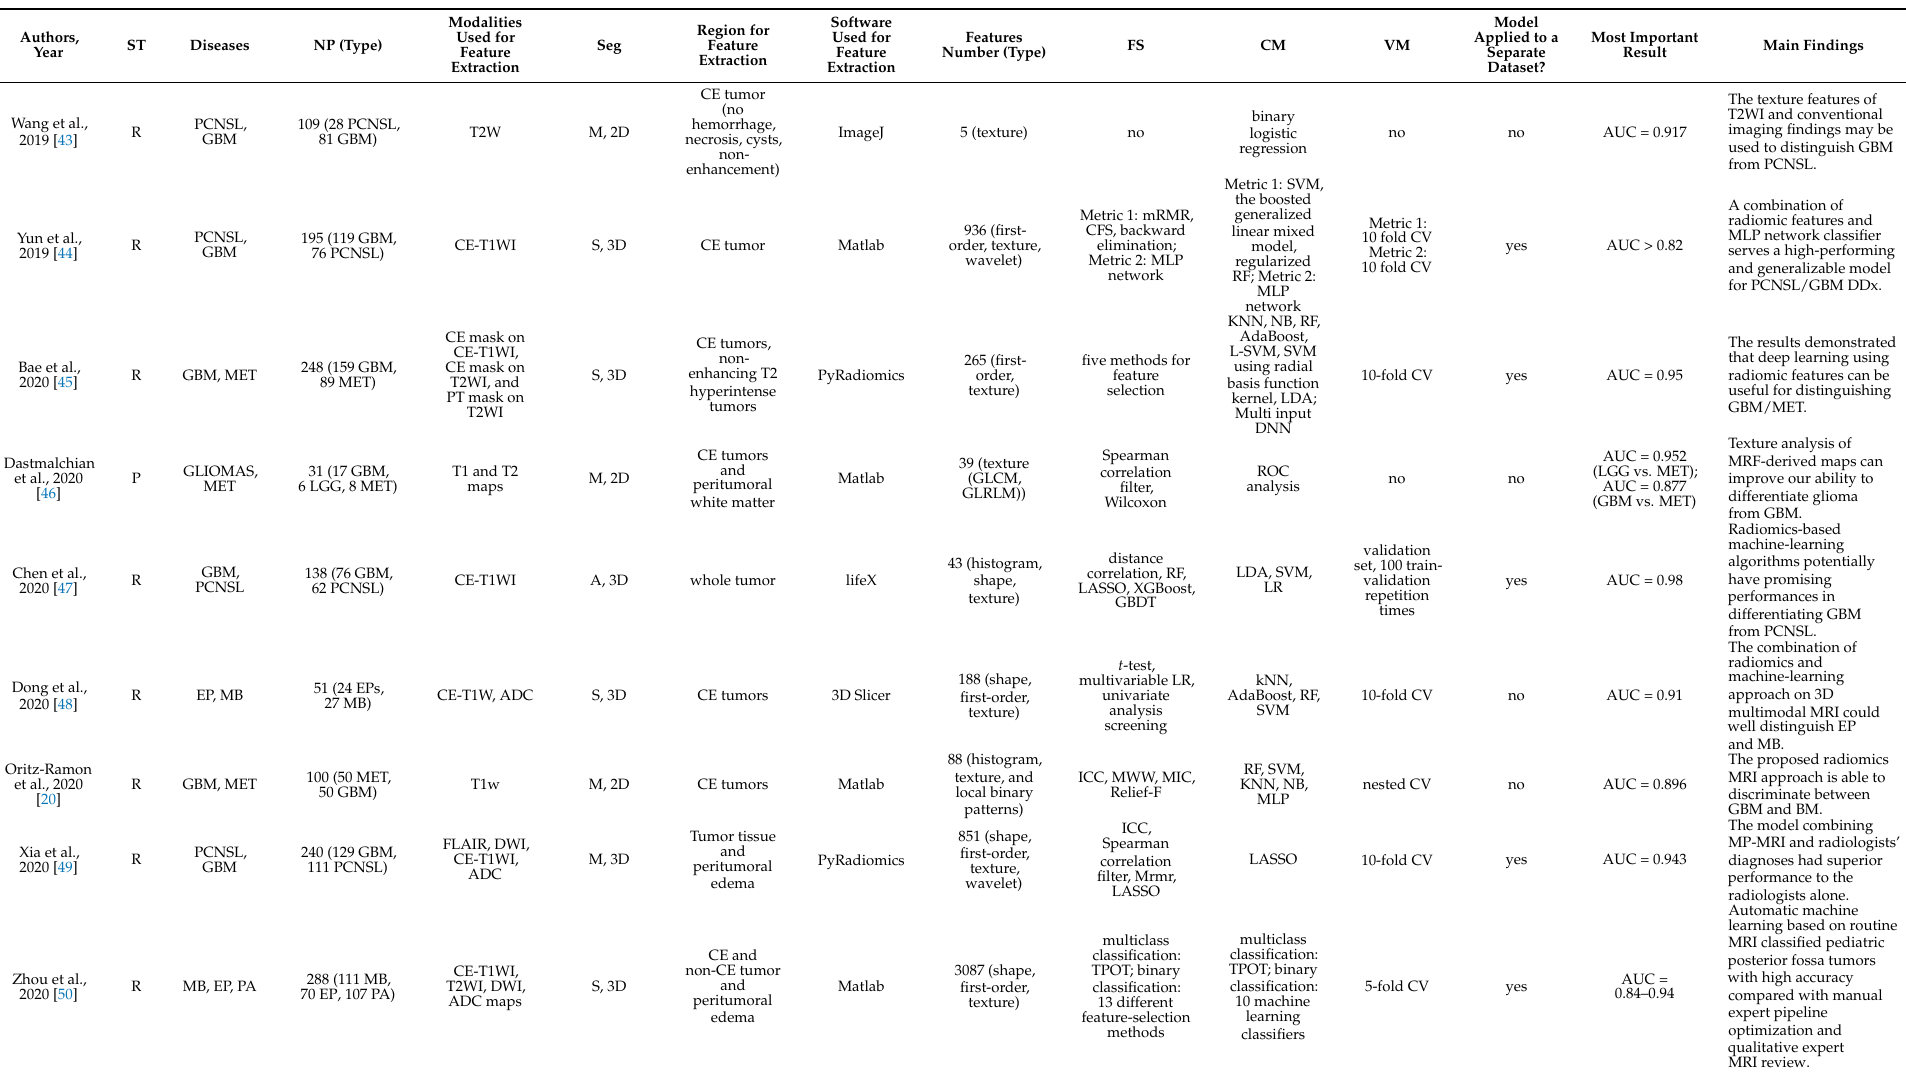
classification: 13different feature-selection